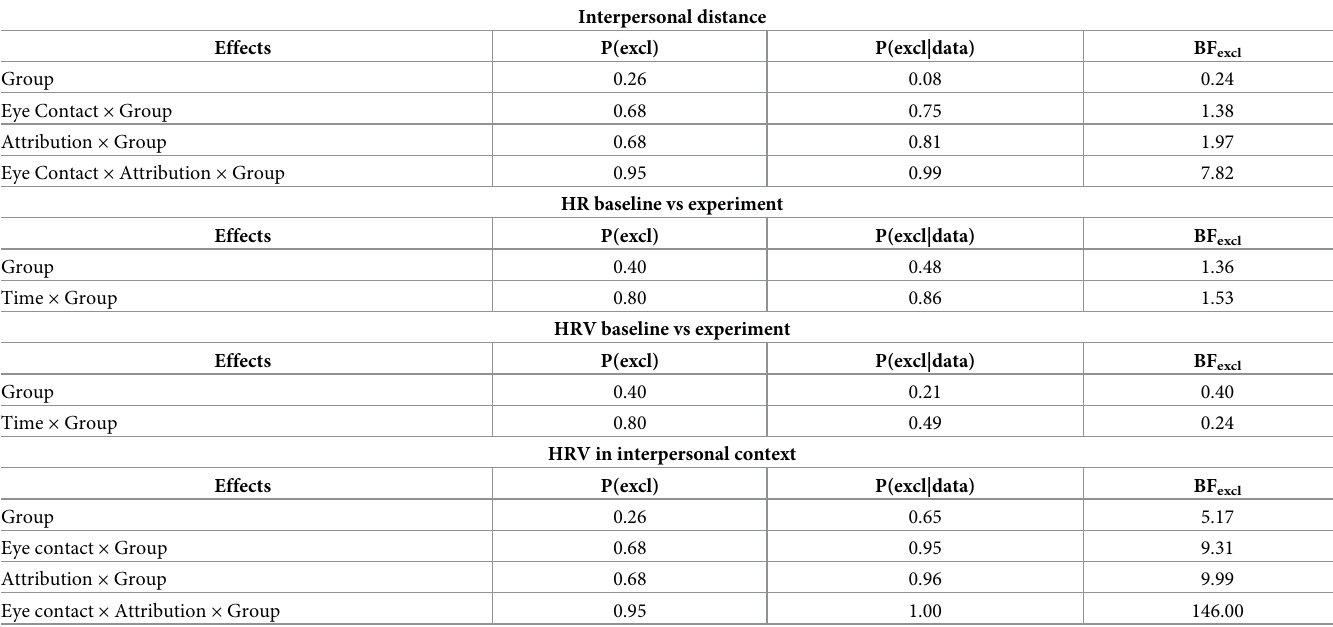
Table 2. Bayesian ANOVA: Effects.